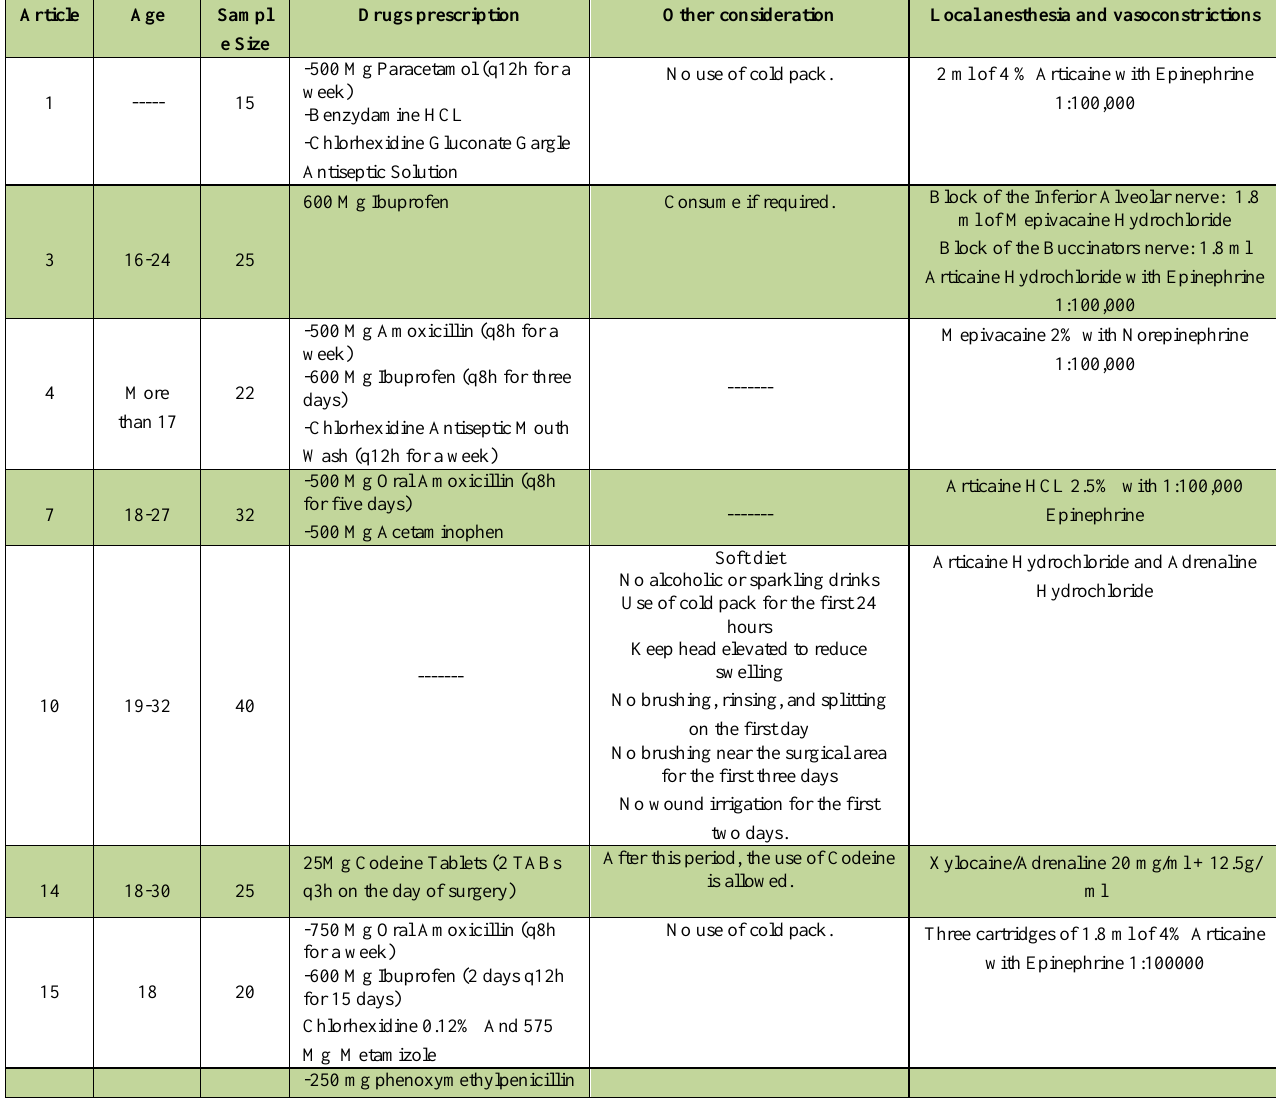
Table 1: Characteristics Of